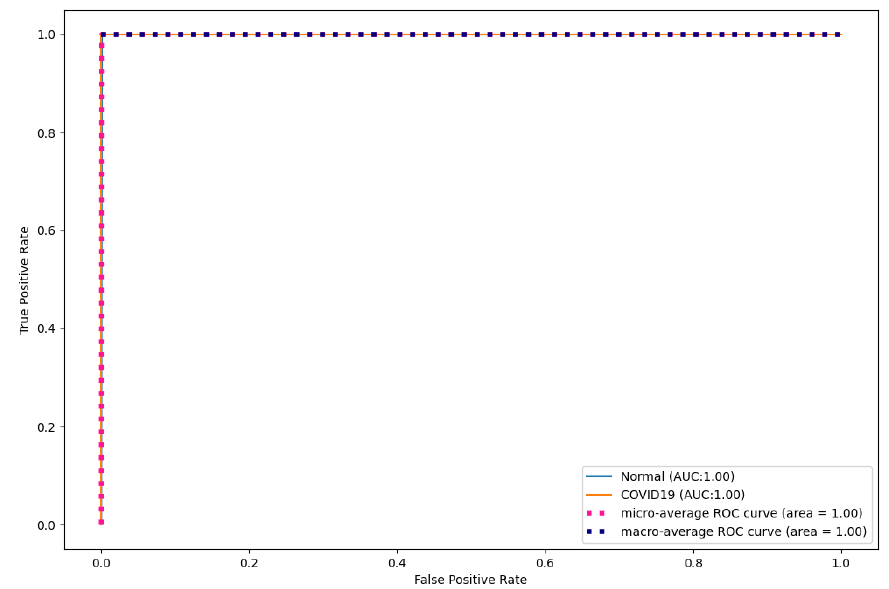
Figure 5. CapsNet ROC curves for CT